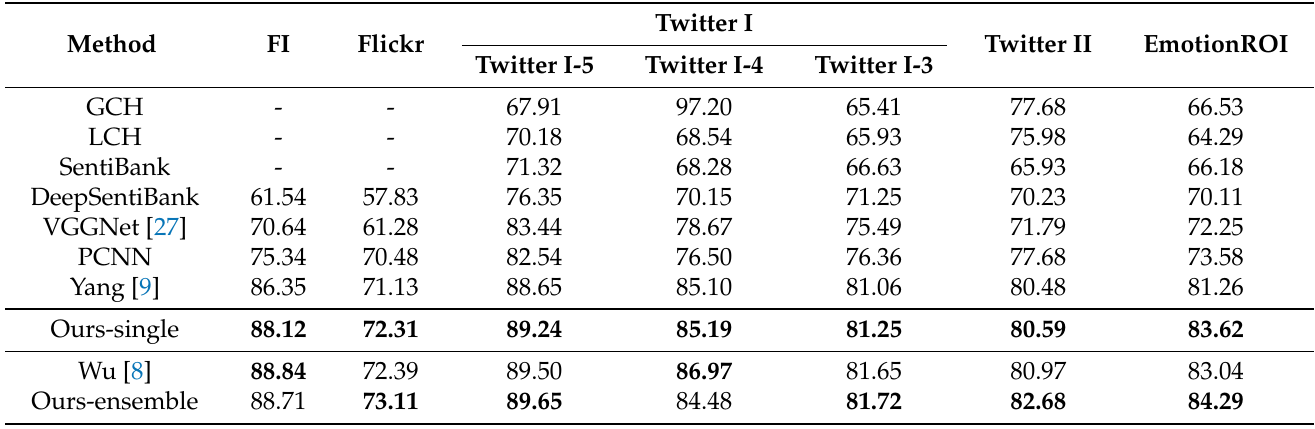
Table 3. Sentiment classification accuracy on FI, Flickr, Twitter I, Twitter II, EmotionROI. Results with bold indicate the best results compared with other algorithms.